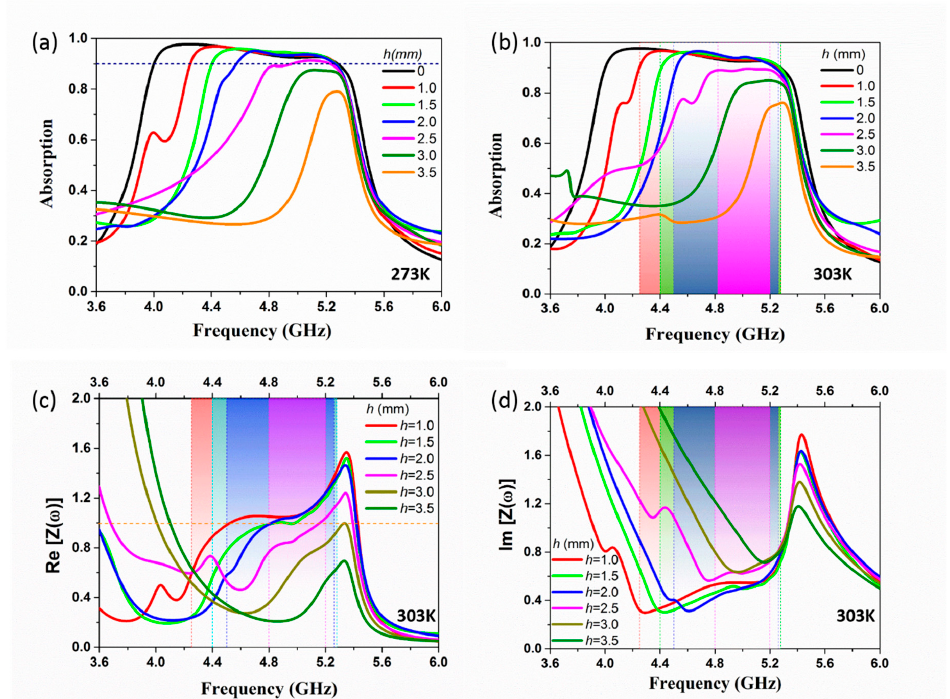
Figure 3. Simulated absorption spectra with respect to the height of water at temperature of ( a ) 273 K and ( b ) 303 K. Calculated effective values of impedance at 303 K for ( c ) real and ( d ) imaginary parts. All color ranges denote the corresponding absorption over 90%.